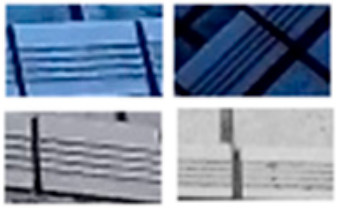
Figure 9. Positive training samples.